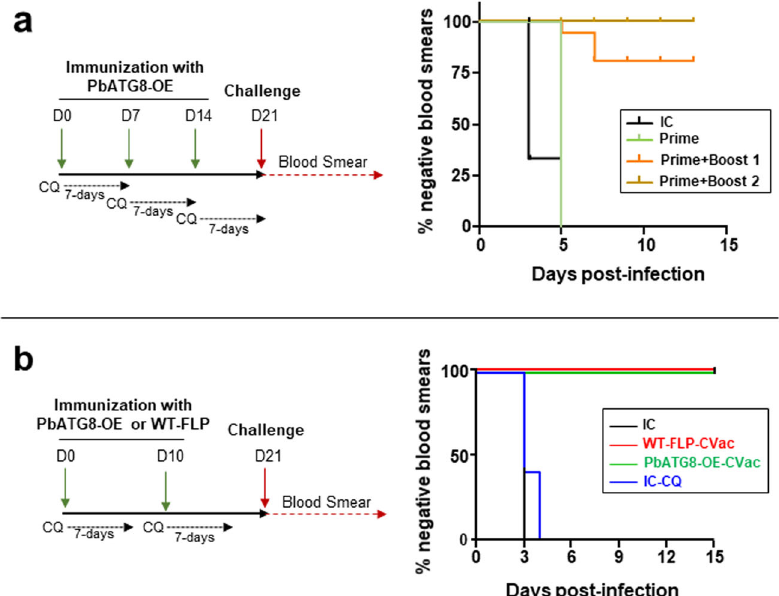
Fig. 3 Immunization with PbATG8-OE-CVac protects mice. a Dose-dependent protection elicited by PbATG8-OE-CVac. Protocol for immunization with PbATG8-OE parasites and challenge under CVac (PbATG8-OE-CVac). Swiss-Webster mice immunized with 10 4 sporozoites from the PbATG8-OE strain and treated with chloroquine (0.8 mg/mouse) intraperitoneally for 7 days, starting from the day of sporozoite injection. Three separate groups ( n = 5) were immunized: fi rst group received one dose of PbATG8-OE parasites at D0 [Prime]; second group received two doses 7 days apart [Prime + Boost 1]; third group received three doses 7 days apart [Prime + Boost 2]. All mice were challenged on D21 and parasitemia was monitored daily by thin blood smears, starting D3 post-challenge until D15. Kaplan – Meier survival plot showing days to blood stage infection after challenge with 10 4 WT-Pb-ANKA sporozoites on D21. IC: Naïve infection control ( p = 0.0039 for [IC] vs. [Prime]; p < 0.0001 for [Prime vs. [Prime + Boost1]; p = 0.0391 for [Prime + Boost1] vs. [Prime + Boost2], measured by log-rank Mantel – Cox test. b Time to blood stage infection during effector challenge. Protocol for immunization with PbATG8-OE or WT-FLP parasites and challenge under CVac. Swiss-Webster mice immunized with two doses of 2 × 10 4 sporozoites from the WT-FLP or PbATG8-OE strain under 7 days of chloroquine treatment (0.8 mg/mouse) 10 days apart prior to challenge on D21. Parasitemia was monitored for 15 days starting from D3 post- challenge. Kaplan – Meier survival plot showing days to blood stage infection after challenge with 10 4 WT-Pb-ANKA sporozoites. Two control groups included one infection control (IC) and one chloroquine control (IC-CQ) in which mice received chloroquine but no sporozoites. n.s. for [IC] vs. [CQ-IC]; p < 0.01 for [CQ-IC] vs. [WT-FLP-CVac] and for [IC-CQ] vs. [PbATG8-CVac], measured by log-rank Mantel – Cox